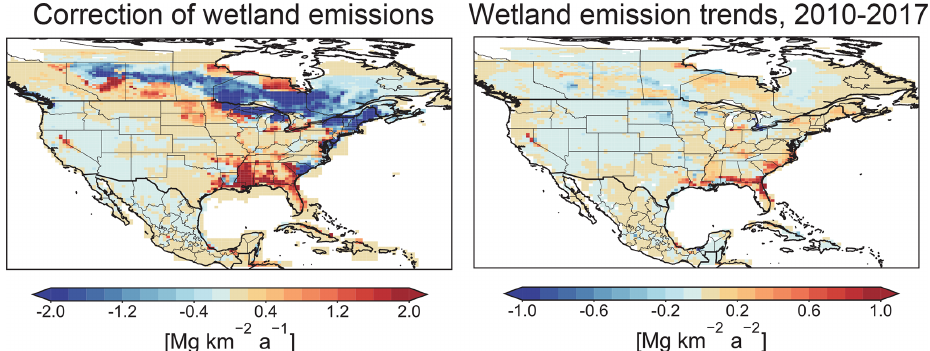
Figure 11. Posterior correction and linear trends for 2010–2017 wetland emissions in North America. The posterior correction factors are relative to the 2010–2017 mean of the high-performance subset of the WetCHARTs inventory ensemble (Ma et al., 2021). The linear trends are from ordinary linear regression to base inversion results for individual